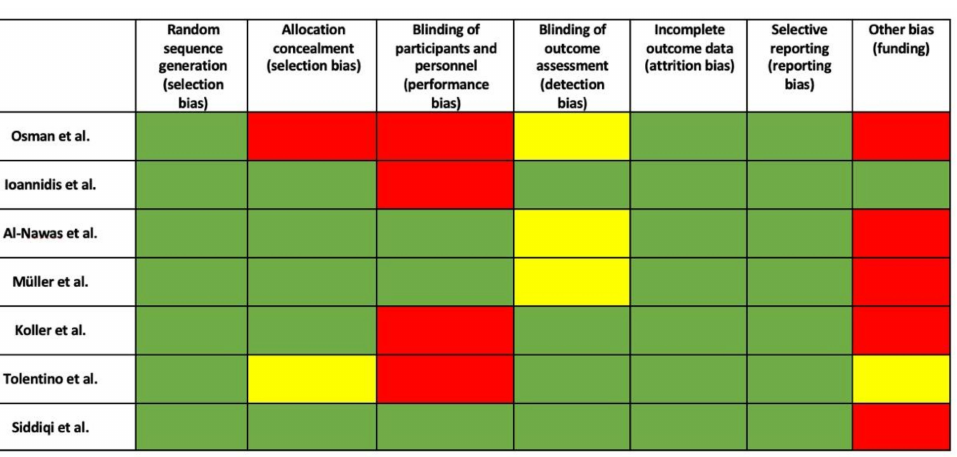
Figure 2. Risk of bias for included RCTs. Low risk (green), unclear risk (yellow), and high risk (red) of bias according to the systematic